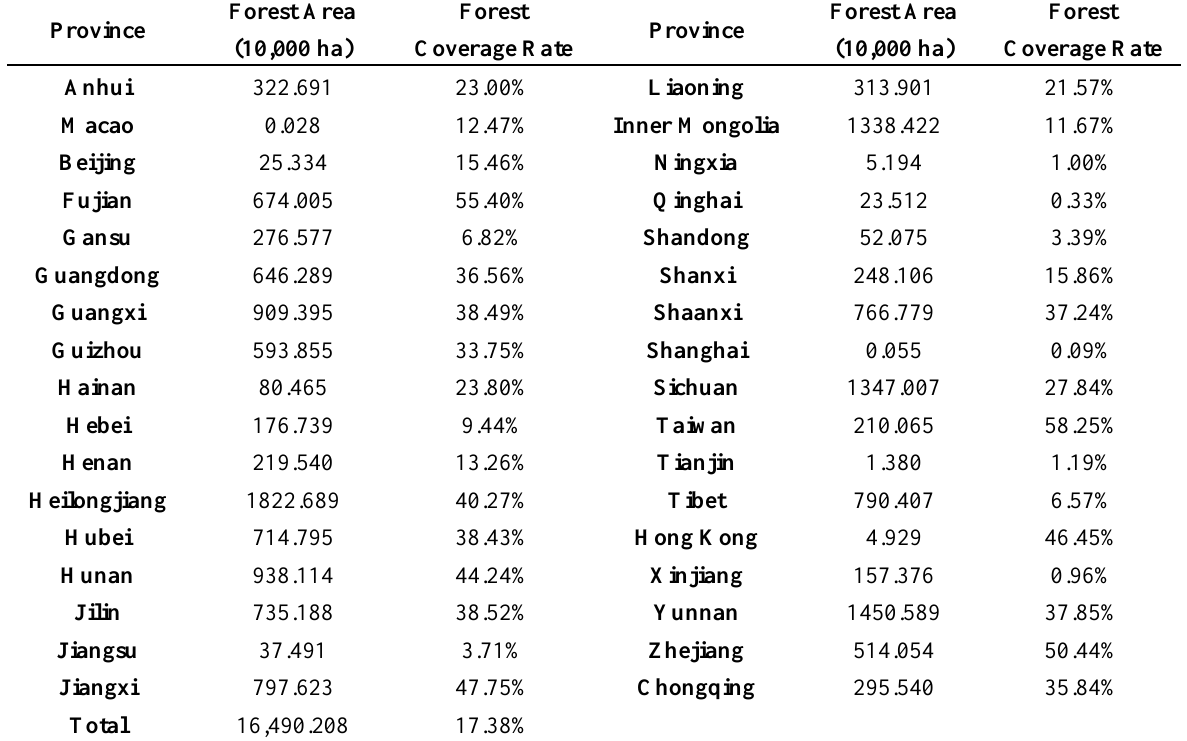
Table 2. Forest extent in different